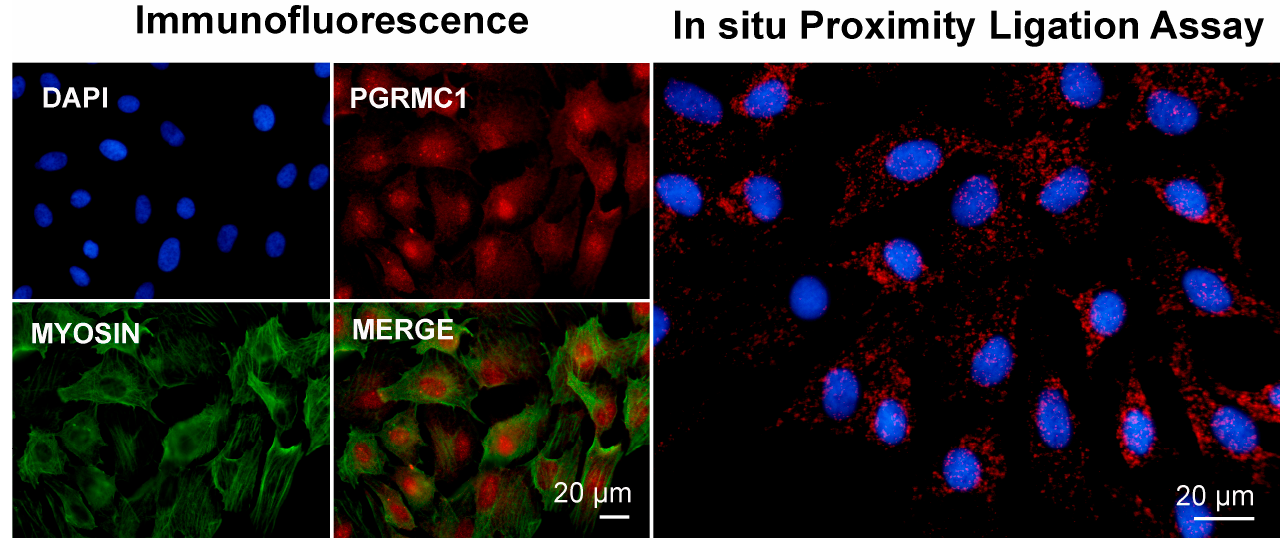
Figure 2. Images showing immunofluorescence and in situ proximity ligation assay (PLA) to assess the association of PGRMC1 and myosin in in vitro cultured bovine granulosa cells. Analysis was conducted as described in [113,163] with proper combination of antibodies, which were rabbit anti- PGRMC1 (Sigma Aldric Prestige antibody HPA002877, 1:50) and mouse monoclonal non-muscle myosin IIA antibody (2B3) (Novus Biological H00004627-M03, 1:100). Nuclei were counterstained with DAPI. Data were presented at the 51st Annual Meeting of the Society for the Study of Reproduc- tion, 10–13 July 2018, New Orleans, Louisiana, USA, and the 2018 Gordon Research Conference in Mammalian Reproduction, 29 July–3 August 2018, Barga, Lucca,